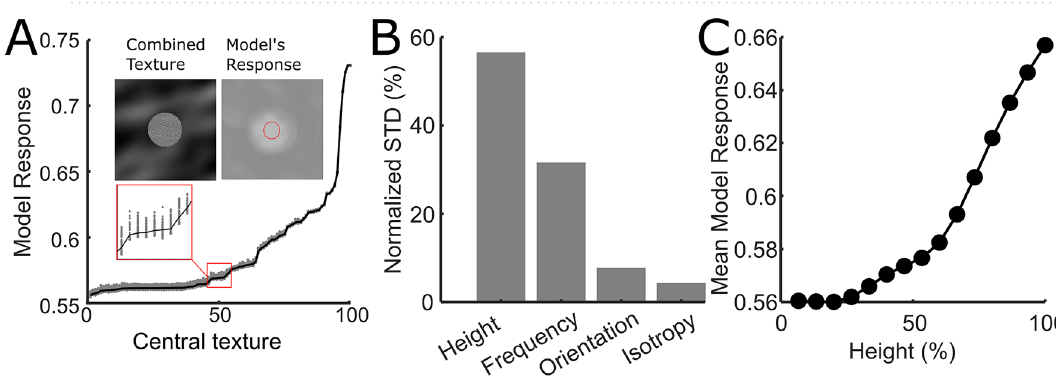
Figure 6. Model’s response. ( A ) Model response to combined textures. The icons illustrate an example of combined texture (left) and the associated model response. Model responses (gray dots) averaged across a finger–sized circle in the center are plotted ( y -axis) against the 100 different central textures ( x -axis). The central textures are sorted according to the model response averaged across their surrounds (black line). ( B ) Variability of model response to the uniform textures across feature levels. Standard deviation on the y -axis for the different features, on the x -axis. The standard deviation is normalized to sum to 1 over the 4 features and expressed in percentage. ( C ) Mean Model response ( y -axis) as a function of the height feature ( x -axis), expressed as percentage of the maximum always above 0.5 indicating that the most and least touched regions can be discriminated based on the model’s predictions for all selection criteria. Also, AUCs are always higher when based on stimulus-specific predictions (red continuous line vs. red dashed line). Crucially, this proves that touch behavior is based—at least in part—on stimulus features. However, the red dashed line is also above 0.5, indicating that the model has learned some map-independent component of the touch behavior. The green lines indicate performance of the mere surface relief. Performance is clearly lower than the DNN model’s, but different from 0.5, when stimulus-specific. When the association between stimuli and trials is broken (i.e. stimulus-independent), Relief shows no predictive power (green dashed line sits on 0.5), as the surface relief is uncorrelated between the different stimuli. Finally, Average Touch has an exceeding predictive power (blue line). This is consistent with the knowledge that touch behavior is highly stereotypical. For statistical testing we averaged across selection criteria and used t -tests on individual values to compare between stimulus-specific and stimulus-independent performance, for each model. t -tests were also used to compare the performance of the DNN Model to the one of the other predictors. Average AUCs are shown in Fig. 4B. The DNN Model performs significantly better than the Relief, t (11) = 11.25, p < 0.0005 but worse than Average Touch, t (11) = − 6.56, p < 0.0005. DNN model performs better than its stimulus-independent predictions, t (11) = 5.37, p < 0.0005, indicating that the model has learned to predict touch behavior based on stimulus proper- ties. This is true also for Relief , t (11) = 4.49, p < 0.001. As stimulus-independent surface relief has no predictive power by definition, this latter test only reveals that Relief can significantly predict touch behavior. In order to rule out that the feature-based predictive power of the model is due to over-fitting, we cross- validated our results. To do so, we iteratively excluded one participant from our ground-truth data, and trained the model on the remaining. Then, we repeated the AUC analysis on the participant we left out. We therefore trained one model per participant on the data of the other participants. Figure 5A shows the AUC averaged across models. Performance is significantly better when predictions are stimulus-specific, as indicated by a t -test on AUCs averaged across selection criteria, t (11) = 4.96, p < 0.0005.